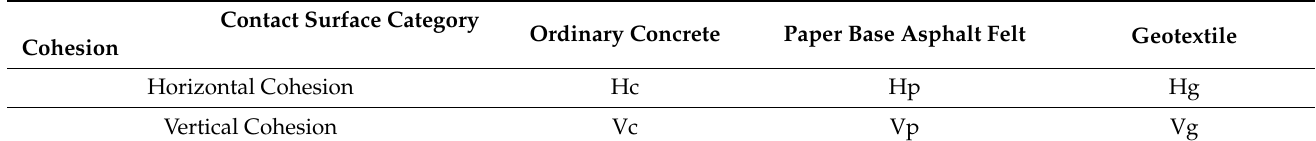
Table 1. Test block classification table.